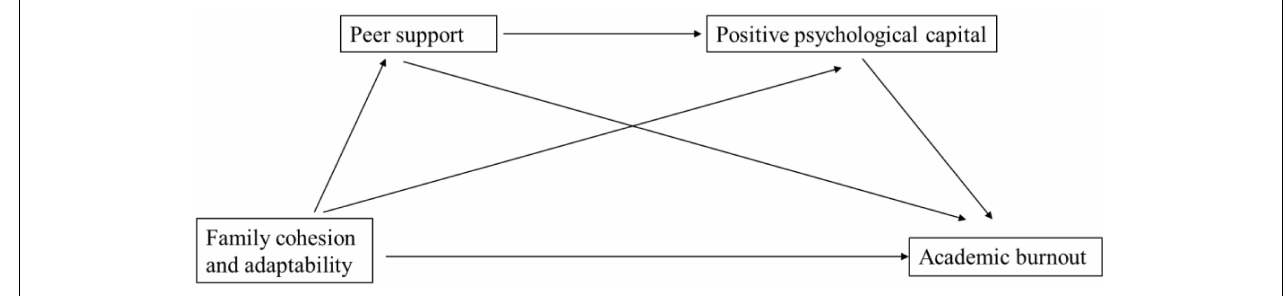
FIGURE 1 | The proposed conceptual framework of family cohesion and adaptability, academic burnout, peer support, and positive psychological capital.